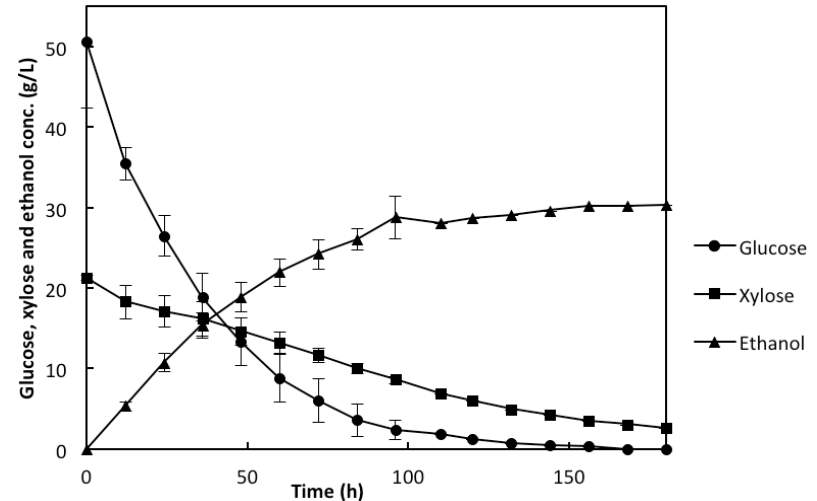
Figure 4. Concentration (g/L) profiles of glucose, xylose, and ethanol during the use of rMBR in the liquid fraction of the prehydrolyzed pretreated wheat straw used as xylose-rich lignocellulosic material. The values presented are mean values of two experiments, with error bars as the standard deviation between the two